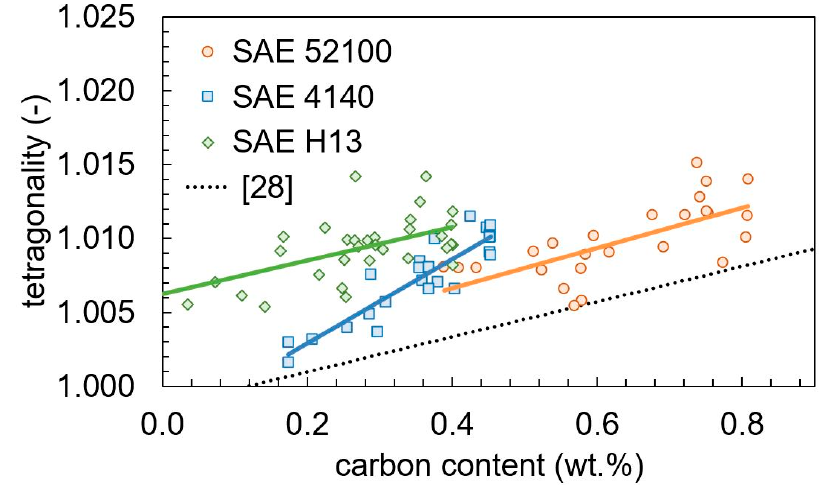
Figure 14. Tetragonality in dependency on the calculated carbon content compared with a literature reference [28].